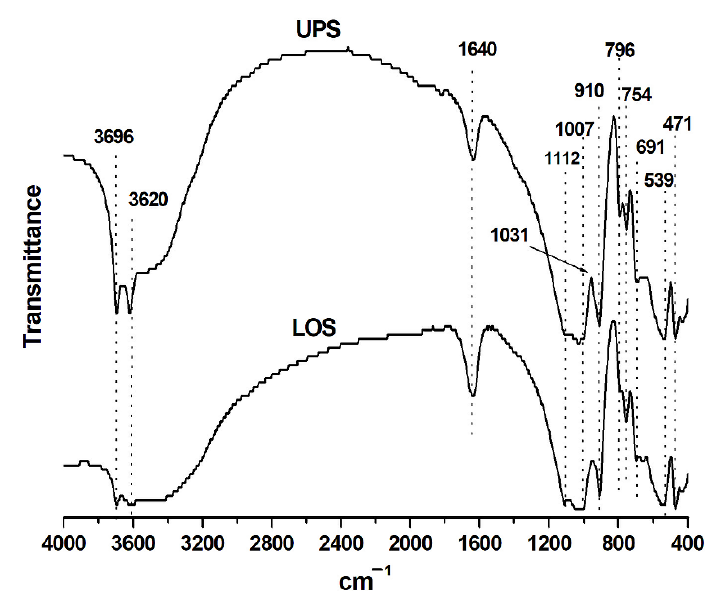
Figure 4. FT-IR graphs of the UPS and LOS samples.